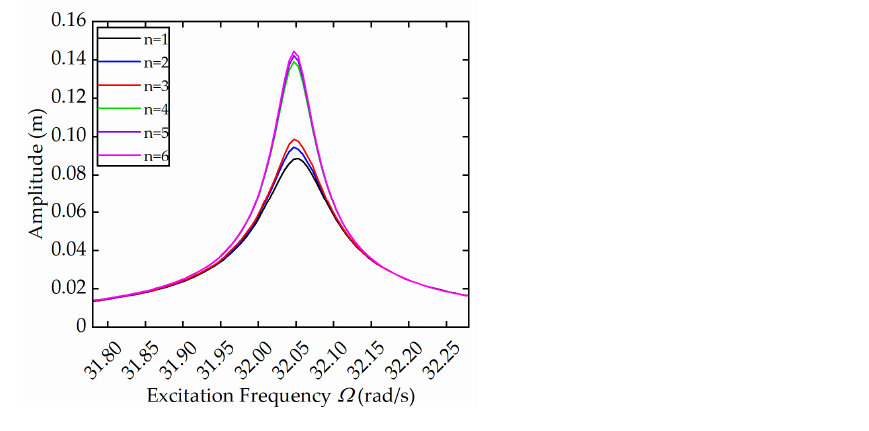
Figure 4. Frequency responses of the linear dynamic model with the first n modes.